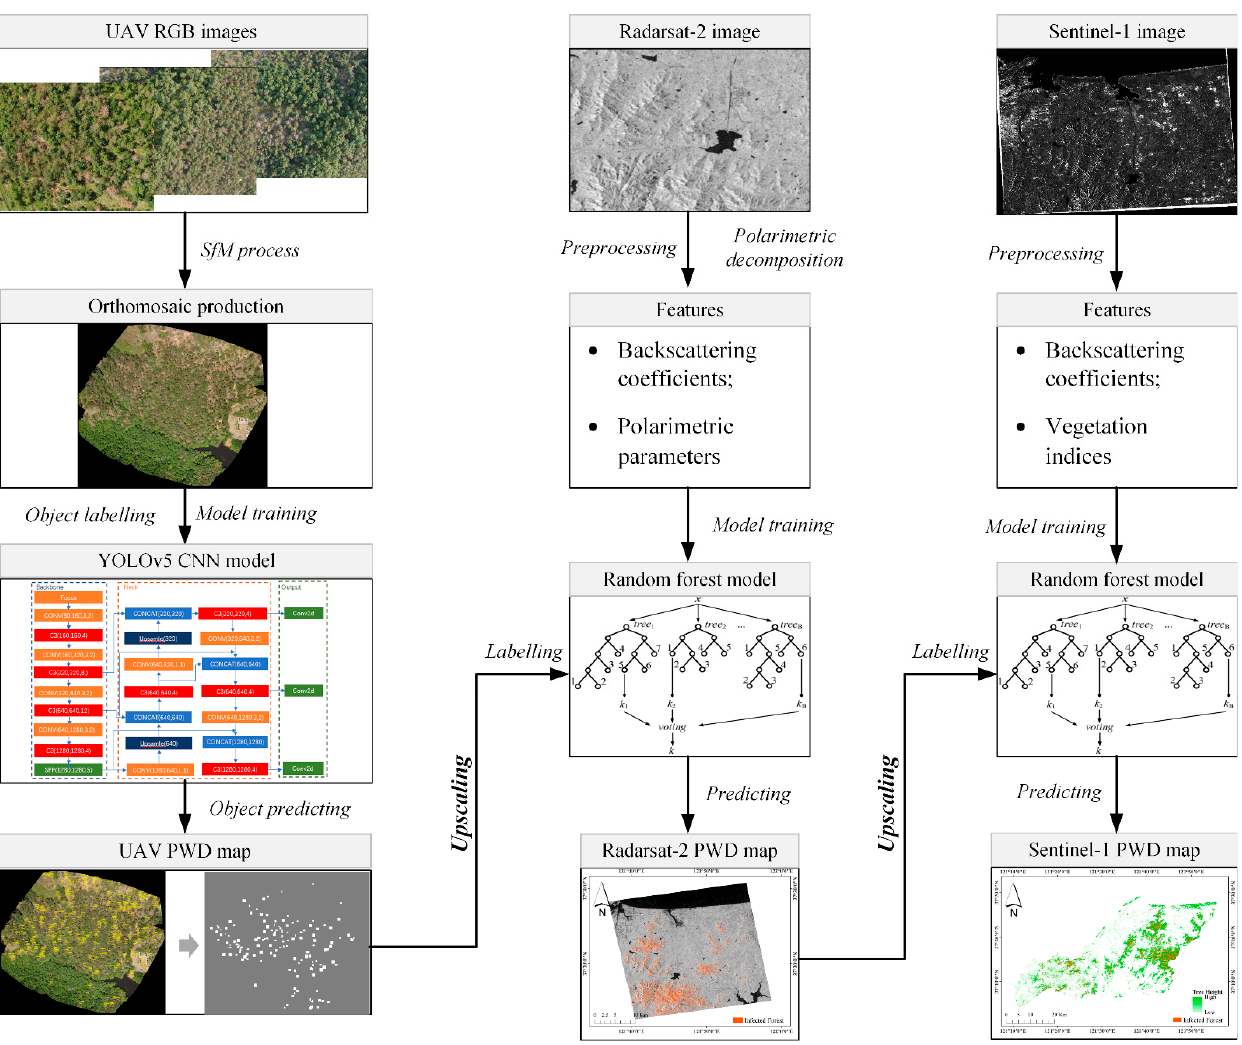
Figure 2. The workflow of predicting regional PWN infestation map using UAV RGB images, Radarsar-2 imagery, and Sentinel-1 imagery.